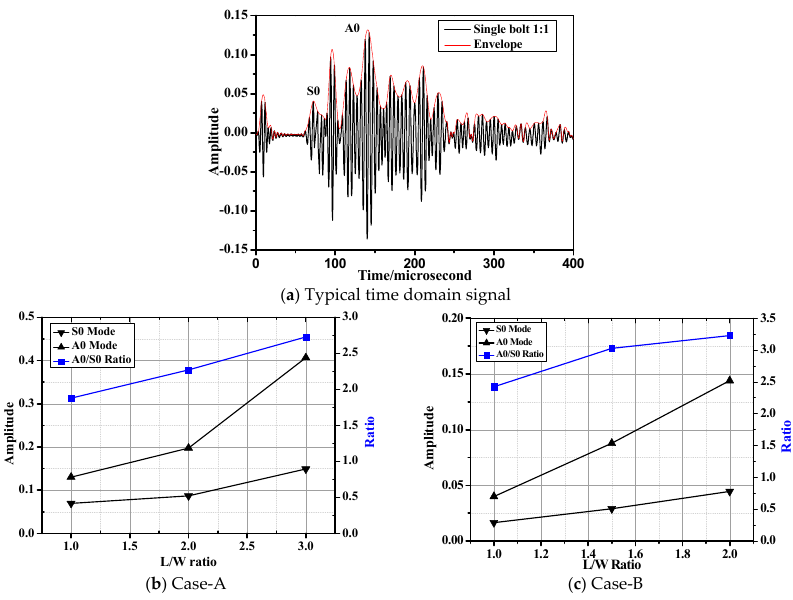
Figure 5. Waveform characteristics and the amplitude tendency in different composite bolted joints without tensile load (the applied torque on the bolts in the joints is 20 N·m). Also, the interface between two jointed composite plates could affect the wave energy and cause the wave amplitude decline by reflecting and scattering during its propagation. As known, in the